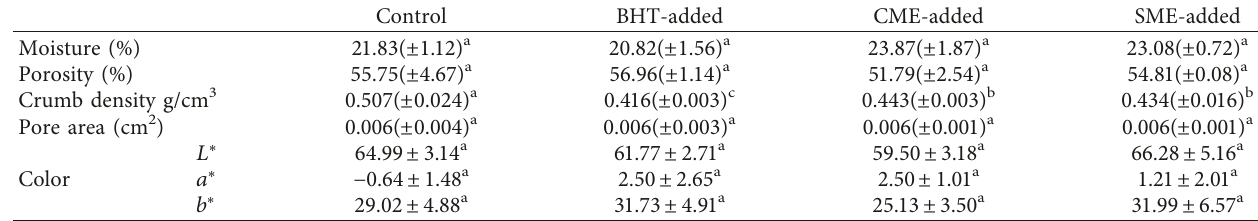
Table 3: Physical parameters of